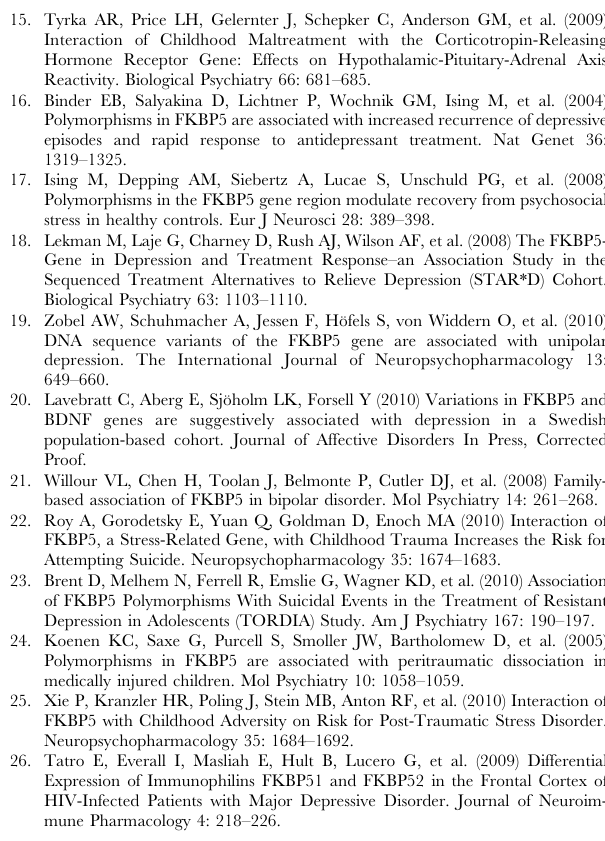
Figure S1 Measured regions for the mapping. Coordi- nates: Interaural 4.98 mm, Bregma 1.18 mm. IG indusium griseum, S septum, CP caudate putamen, Pir piriform cortex (layer 2), NAcC core of the nucleus accumbens, NAcS shell of the nucleus accumbens. (TIF) Figure S2 Measured regions for the mapping. Coordi- nates: Interaural 3.58 mm, Bregma -0.22 mm. BNST bed nuclei of the stria terminalis. (TIF) Figure S3 Measured regions for the mapping. Coordinates: Interaural 2.86 mm, Bregma -0.94 mm. PVN paraventricular nucleus of the hypothalamus, AHA anterior hypothalamic area. (TIF) Figure S4 Measured regions for the mapping. Coordi- nates: Interaural 2.74 mm, Bregma -1.06 mm. Hb habenular nucleus, Rt reticular nucleus. (TIF) Figure S5 Measured regions for the mapping. Coordi- nates: Interaural 1.86 mm, Bregma -1.94 mm. DG dentate gyrus, VmHN ventromedial hypothalamic nucleus, MA medial amyg- dala, CeA central amygdala, BLA basolateral amygdala. (TIF) Figure S6 Measured regions for the mapping. Coordi- nates: Interaural 1.34 mm, Bregma -2.46 mm. vPmN ventral premammilary nucleus.